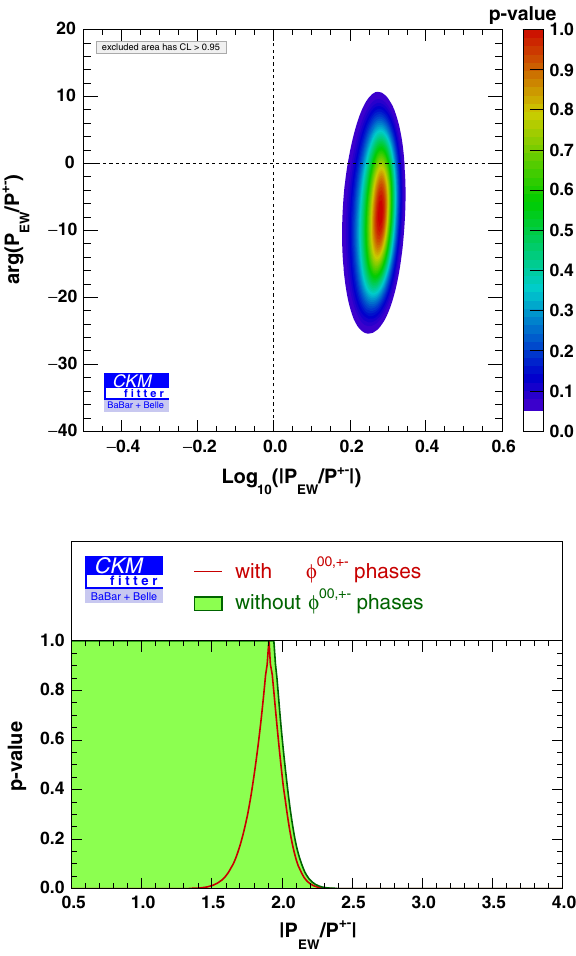
Fig. 9 Top two-dimensional constraint on the modulus and phase of the complex P EW / P +− ratio. Bottom constraint on the ratio, using the complete set of experimental inputs ( red curve ), and removing the BaBar measurement of the ϕ 00 , +− phases from the B 0 → K + π + π 0 Dalitz-plot analysis ( green shaded curve )